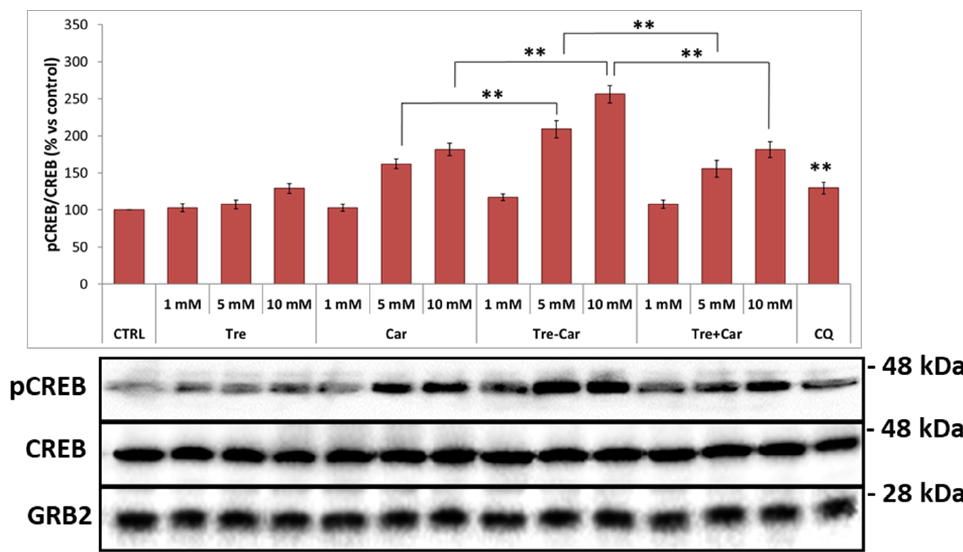
Figure 4. Dose dependent effect of Tre, Car, Tre-Car, Tre + Car mixture or 10µM CQ on CREB phosphorylation. Representative western blotting and densitometric analyses of pCREB in PC12 cells treated for 30 min in RPMI-1640 complete medium without FBS. The phosphorylated level of CREB was reported as ratio over the total CREB protein (** p ≤ 0.01 versus the respective control/treatment). Dashes to the right of the membrane bands show positions of prestained molecular mass marker.